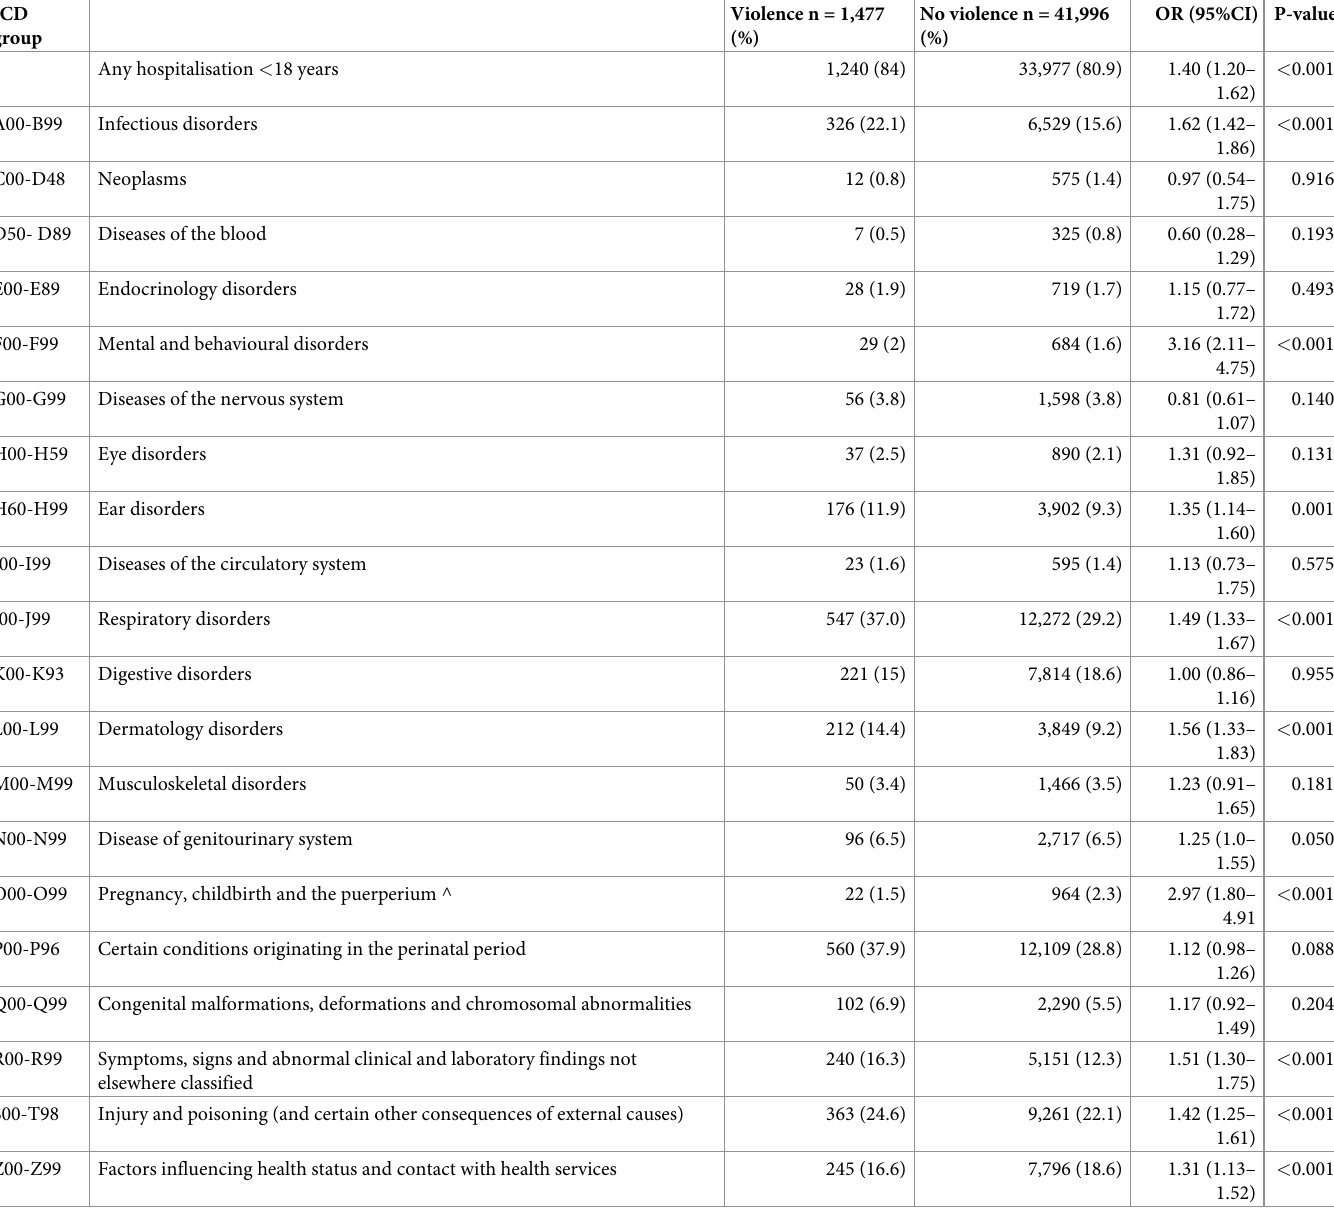
Table 2. Adjusted � principal hospitalisations for children exposed and non-exposed to FDV in prenatal period. ICD